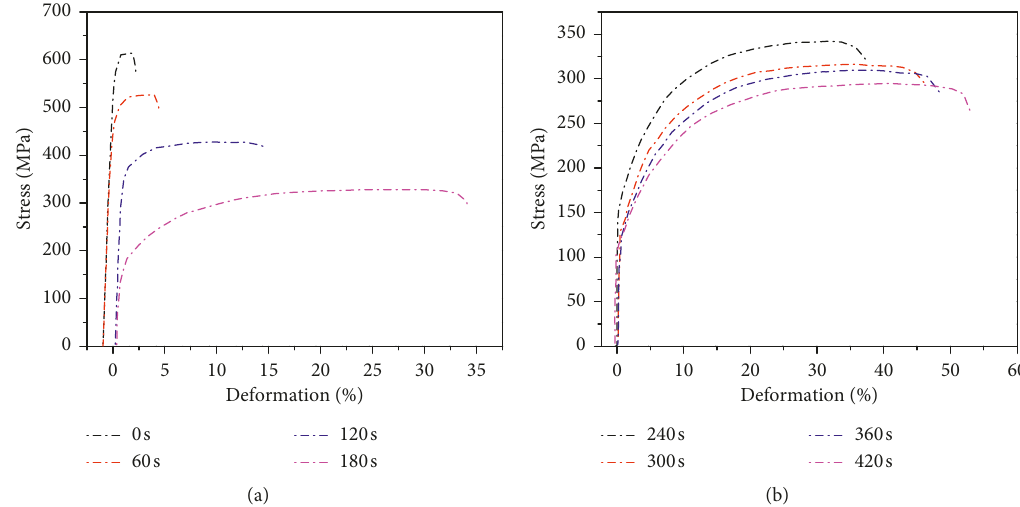
Figure 6: Stress-strain curves obtained for IF steel as a function of different recrystallisation times in the ranges (a) 0–180s and (b) 240–420s at a temperature of 780 °